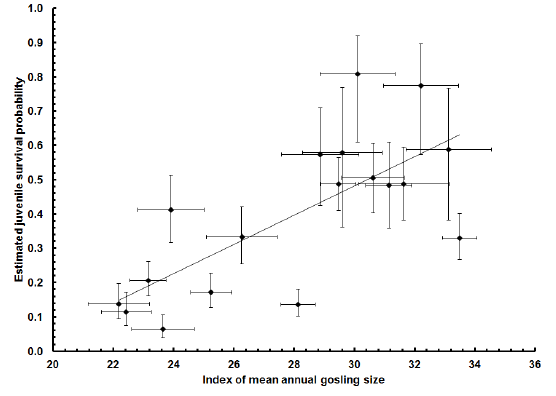
Fig. 6 . The relationship between annual gosling size and annual first-year survival of Canada Geese banded on Akimiski Island, Nunavut. The gosling size covariate was found to explain significant variation in juvenile first-year survival (see text). Bars are 95% confidence limits.